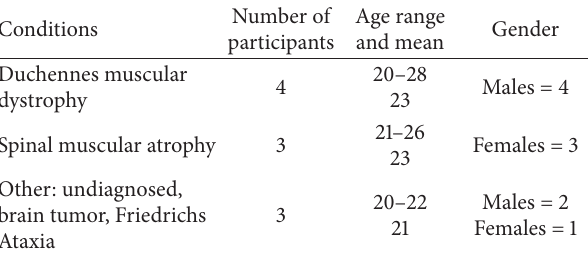
Table 2: Participant characteristics for face-to-face interviews and bulletin board discussion groups 𝑛 = 10